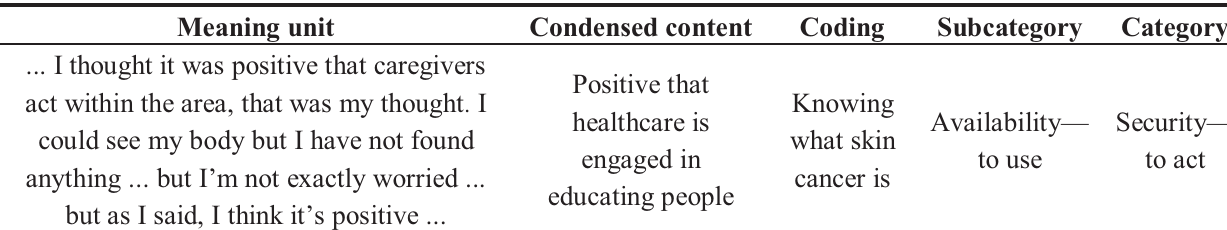
Table 2. Example of description of analysis of content into subcategories that formed a category.